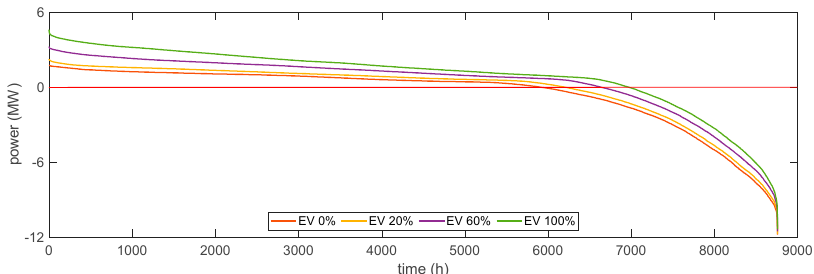
Figure 22. Sorted duration curve of the residual load of cell 13 for a fixed penetration of 60% PV and a variation of the penetration of EV for 3.7 kW charging power and charging strategy 1 and a simulation period of one year (8760 h).